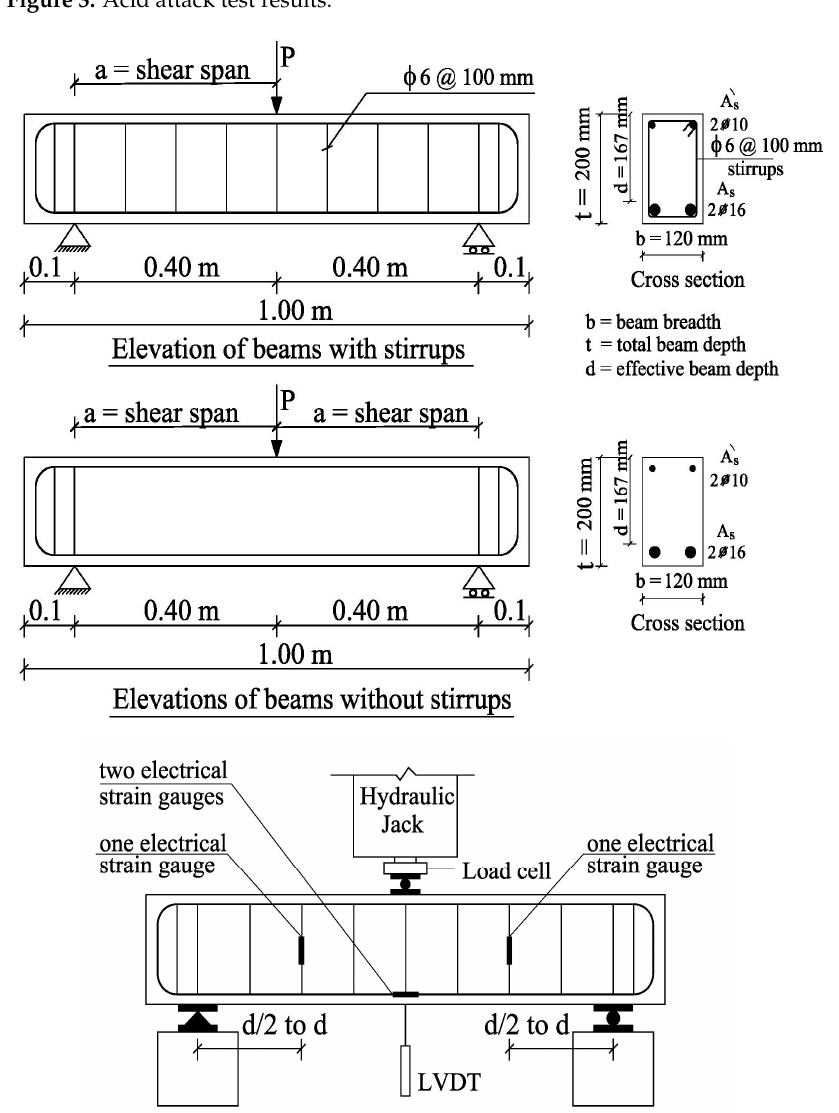
Figure 4. Details of the tested beams and test setup.